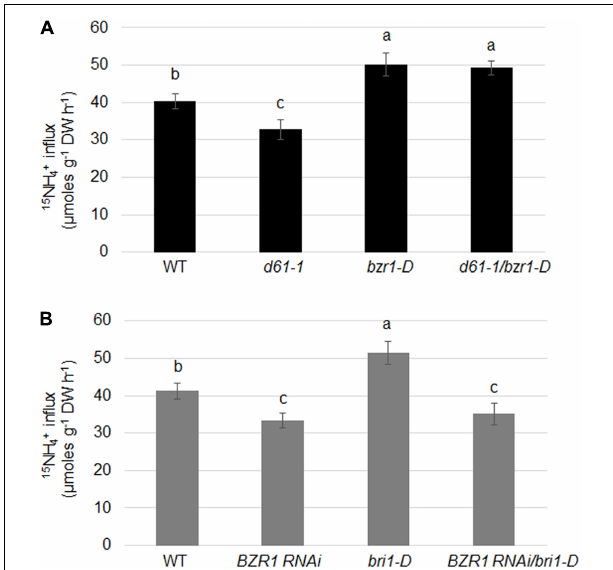
FIGURE 7 | BRI1 and BZR1 effects on NH 4 + uptake in plants. (A) 15 NH 4 + abundance in total 15 N in roots of wild-type, BRI1 mutant d61-1 , gain-of-function mutant bzr1-D , and their cross offspring d61-1 / bzr1-D plants. (B) 15 NH 4 + abundance in total 15 N in roots of wild-type, BZR1 RNAi , BRI1 overexpression line bri1-D , and their cross offspring BZR1 RNAi / bri1-D plants. The 2-week-old hydroponic seedlings were further transferred and cultured in nitrogen-free nutrient solution. Three days later, plant roots were immersed in 200 µ M 15 N-labeled NH 4 + nutrient solution for 6 min. The rate of ammonium uptake by the roots was then determined. 15 NH 4 + abundance in total 15 N in roots was measured after 6 min of 15 NH 4 + uptake. Bars represent means ± SD ( n = 6). The experiments were repeated at least three times. Different letters represent statistically significant differences ( P <